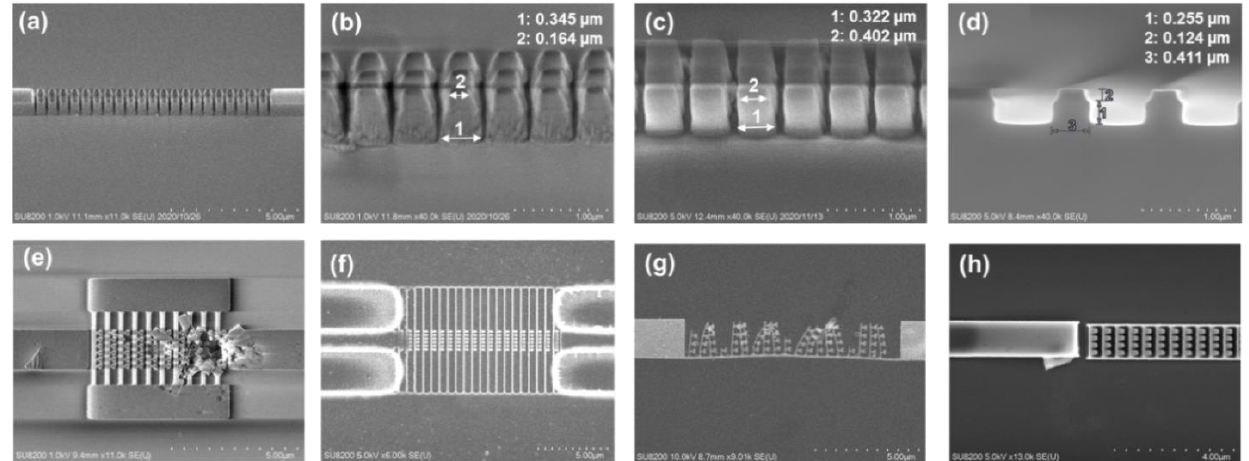
Figure A1. SEM images of ( a – d ) MS-SW, ( e ), ( f ) CWIRE, ( g ) CSAW, and ( h ) SAW; MS-SW for WG thickness H = 500 nm in ( a ) zoomed-out and ( b ) zoomed-in views etched with 20 nm Ni mask, and ( c ) zoomed-in view etched with 40 nm Ni mask. ( d ) Etched by inverse exposure method with EBL resist mask thickness H = 520 nm with etching time of 90 s. CWIRE BG fabricated by ( e ) lift-off and ( f ) inverse exposure methods. Destroyed CSAW and SAW BGs due to ( g ) acid cleaning or ( h ) blower usage on the samples after